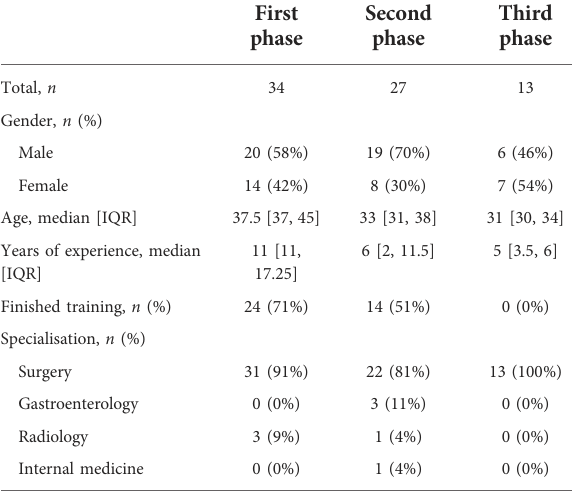
TABLE 1 Participant baseline characteristics, separated by study